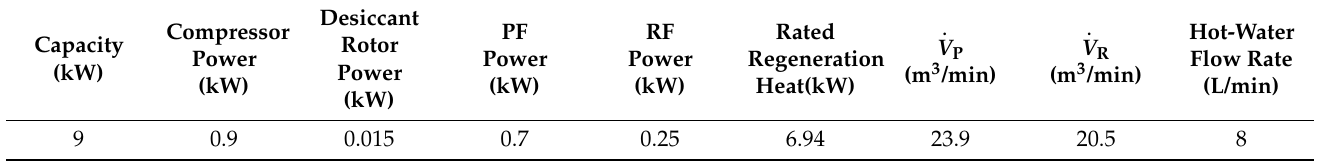
Table 2. Specifications of